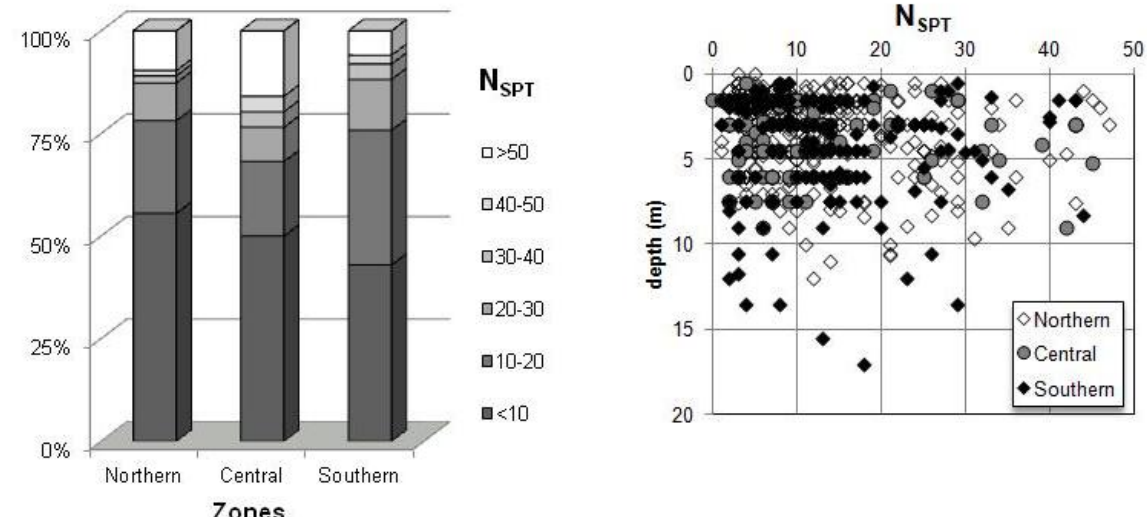
values in the anthropogenic deposits for the three zones. Left: histograms of N SPT (< 50) with SPT